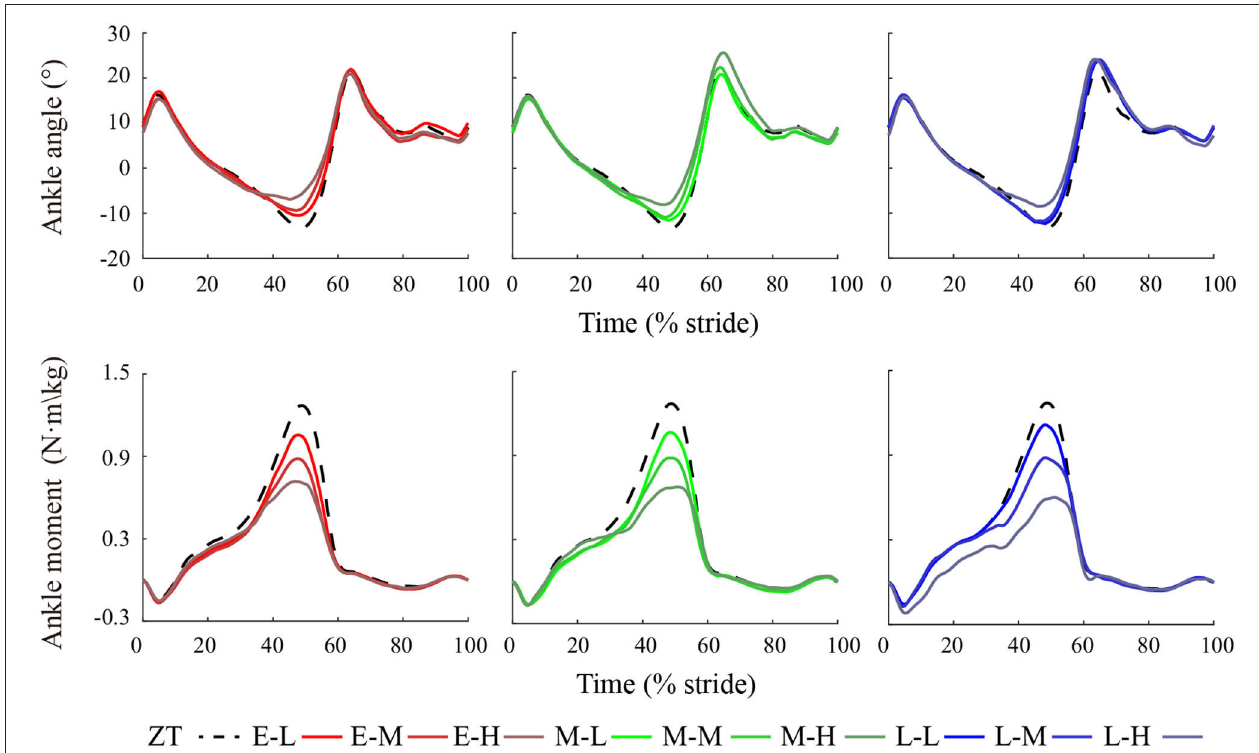
FIGURE 9 | Exoskeleton-side ankle joint angle and biological ankle moment during human walking with different ankle exoskeleton assistance